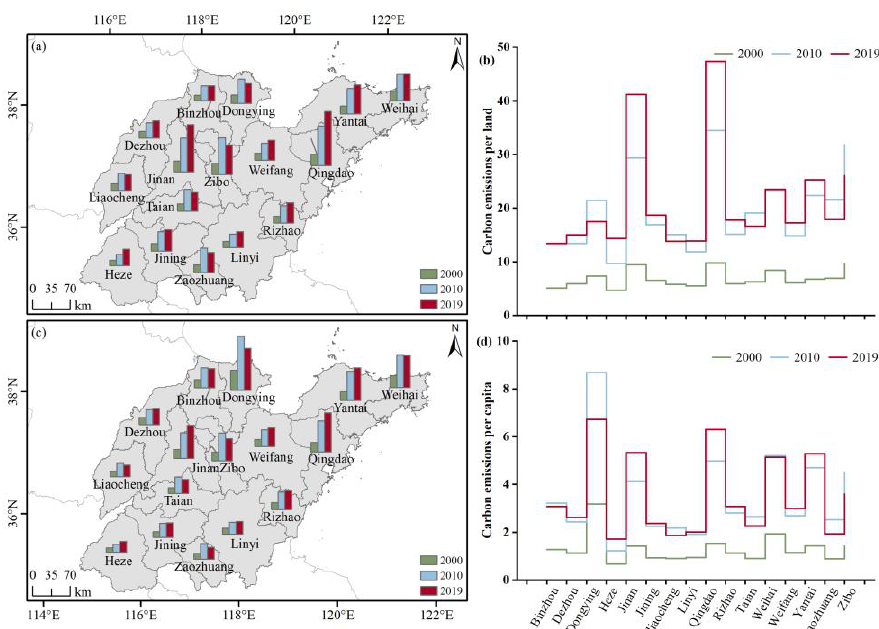
Figure 6. Spatial and temporal variation in carbon emissions related to Shandong Peninsula urban agglomeration during 2000 – 2019. ( a ) Visualization of land-average carbon emissions during 2000 – 2019; ( b ) land-average carbon emissions during 2000 – 2019; ( c ) visualization of carbon emissions per capita during 2000 – 2019; ( d ) carbon emissions per capita during 2000 – 2019.